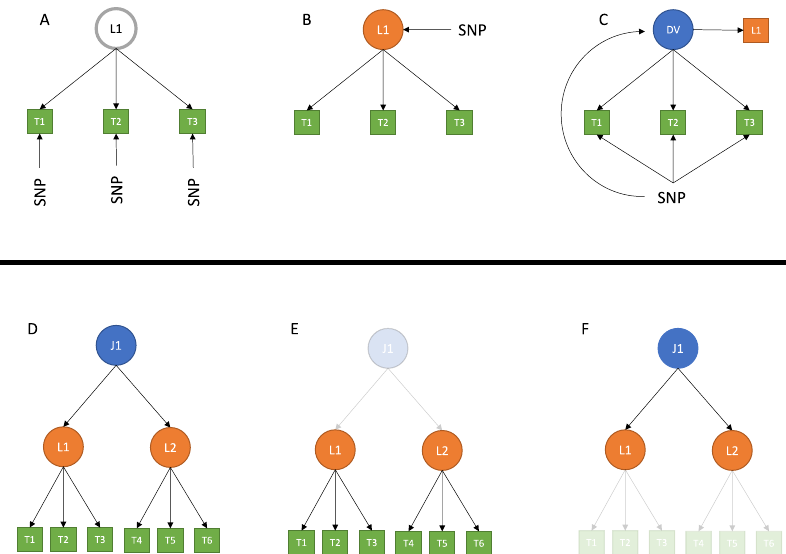
Fig. 7 Strategy to map loci to speci fi c traits. Panels A – C shows how we fi t the SNP effect simultaneously on all food-liking traits in the model. We started with the SNP effect on each observed trait participating in the model ( A ). We then used GenomicSEM to estimate the effect of the SNP on the latent variable, L1, based on the observed ones ( B ). We fi nally used the SNP estimate on L1 as though it were directly observed and created a new dummy latent variable (DV) strongly correlated to L1 (0.99) and fi t the SNP effect on LD and all participating food-liking traits at the same time ( C ). Panels D – F shows